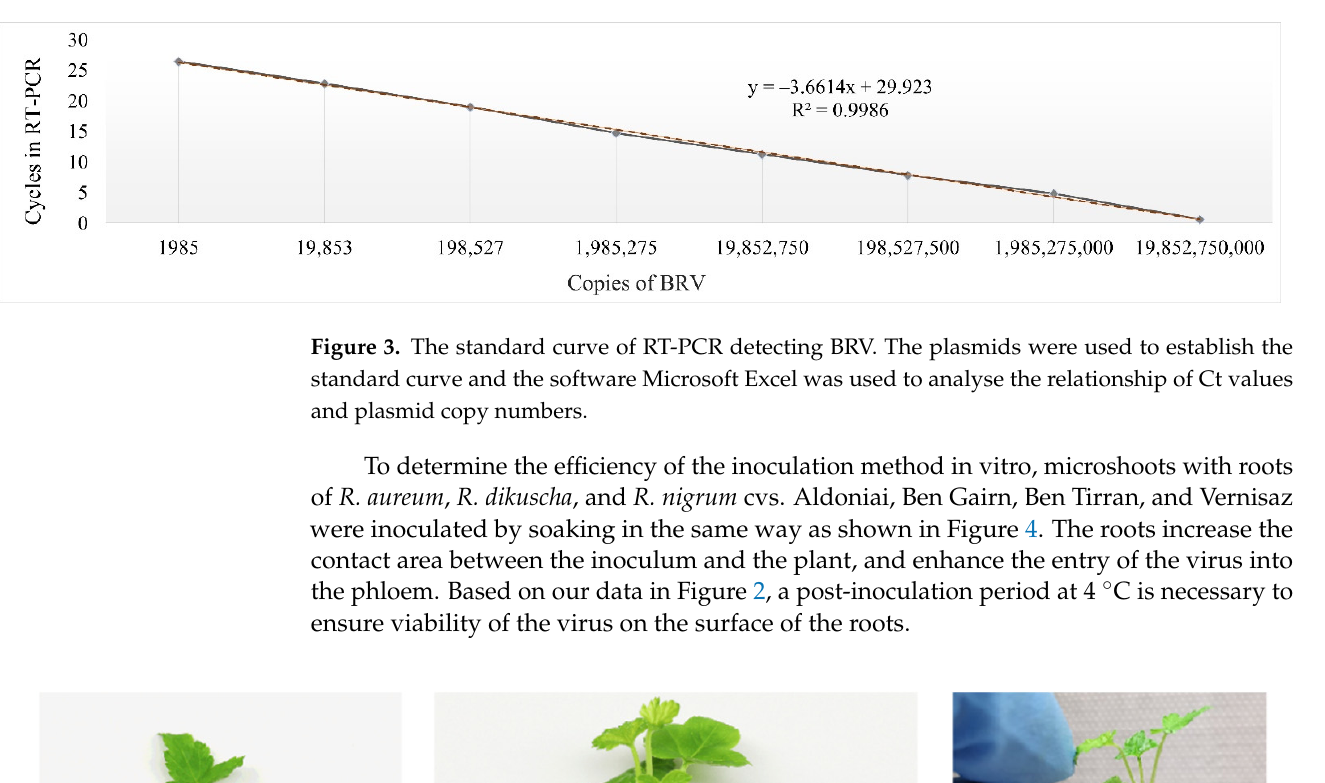
Figure 4. In vitro inoculation of R. nigrum microshoots: ( A ) microshoot before rooting; ( B ) mi ‐ croshoot with roots; ( C ) microshoot soaked in the tube with inoculum.